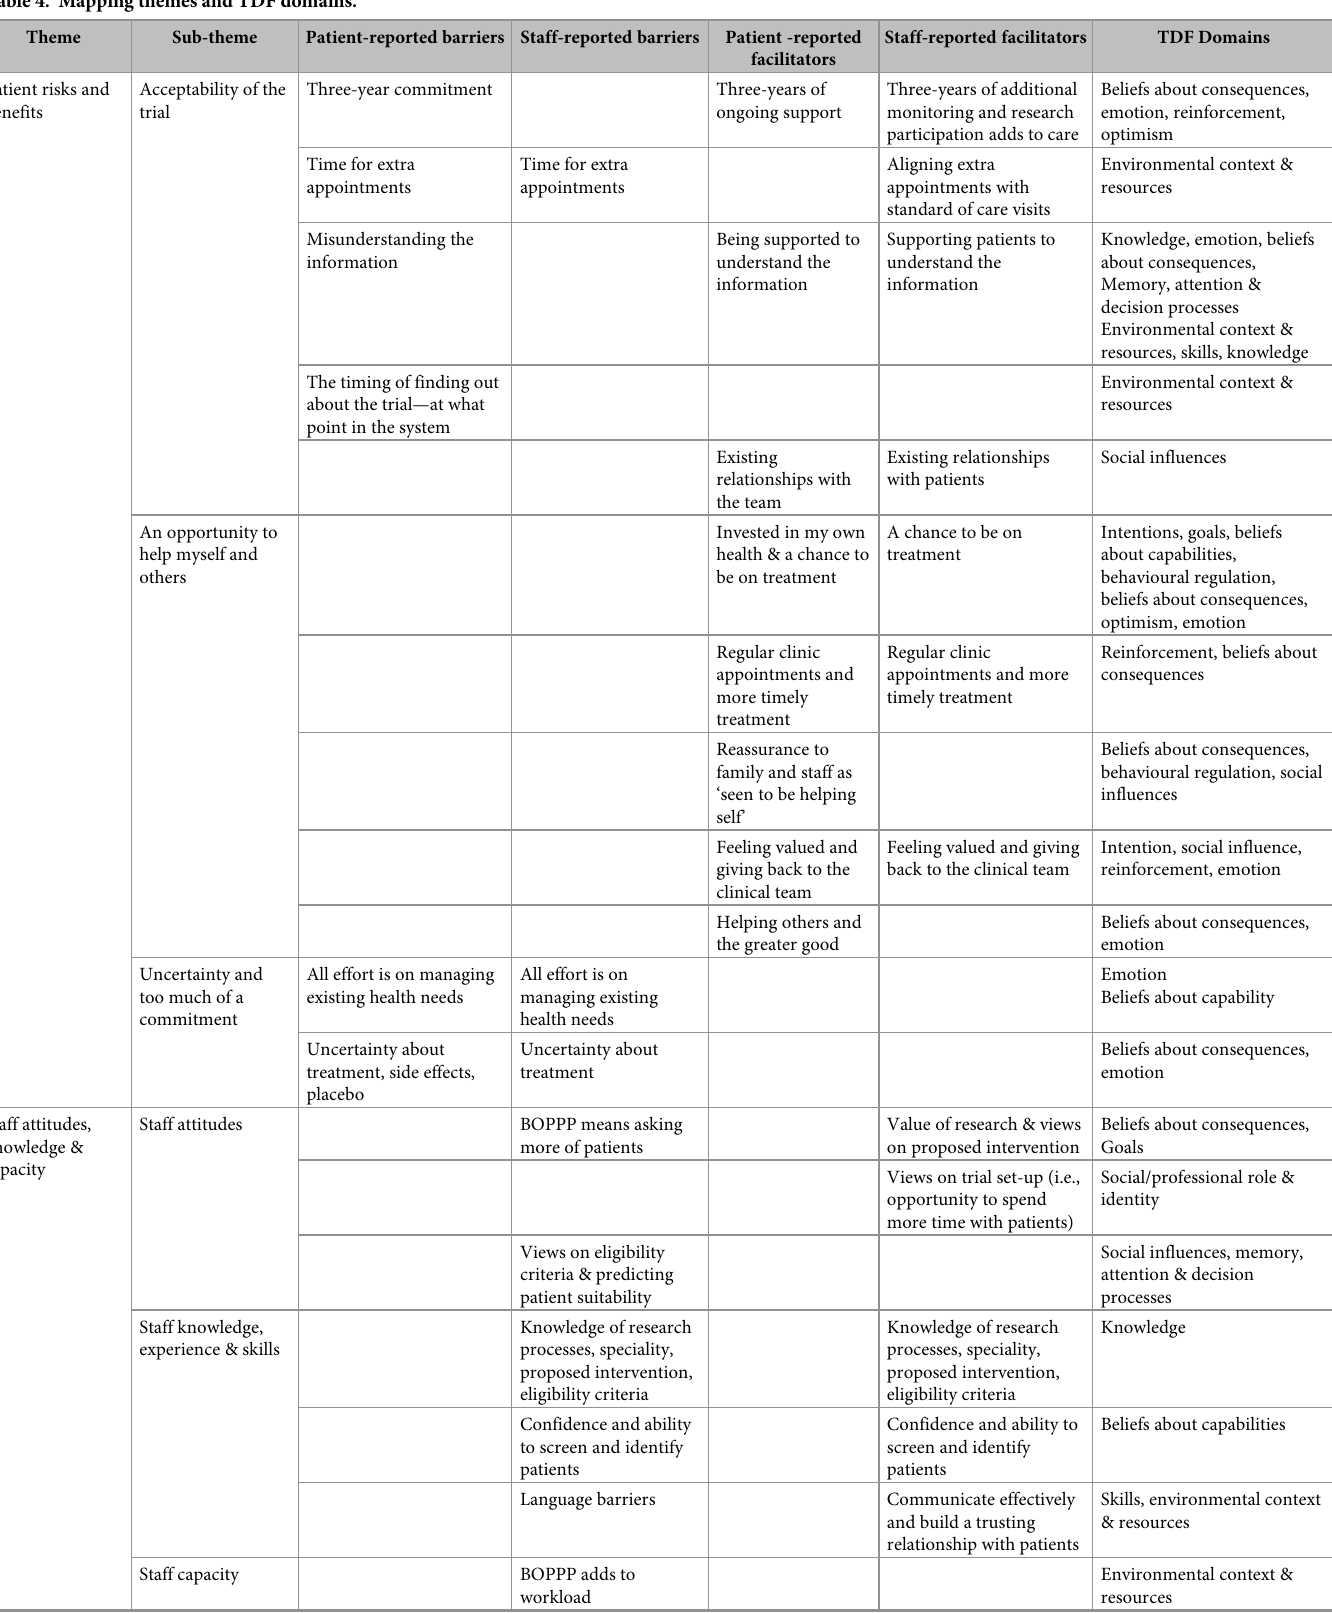
Table 4. Mapping themes and TDF